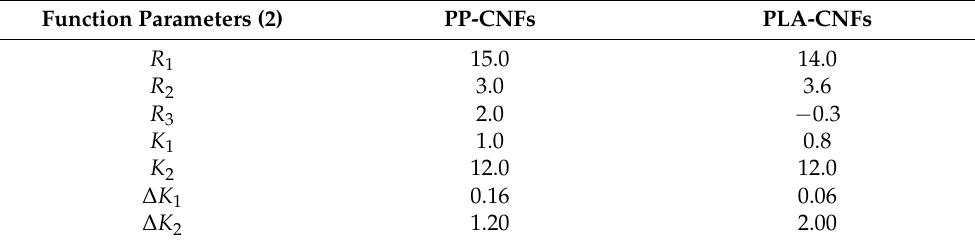
Table 3. Values of function parameters (2) for PP-based and PLA-based composite fibers filled with CNFs. Function Parameters